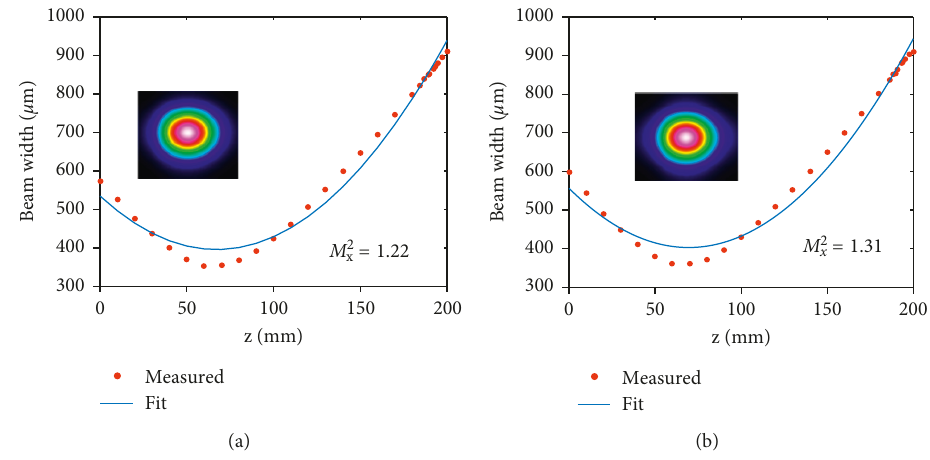
Figure 11: Beam quality of the tuning laser at 1548nm. (a) Configuration 1. (b) Configuration 2.